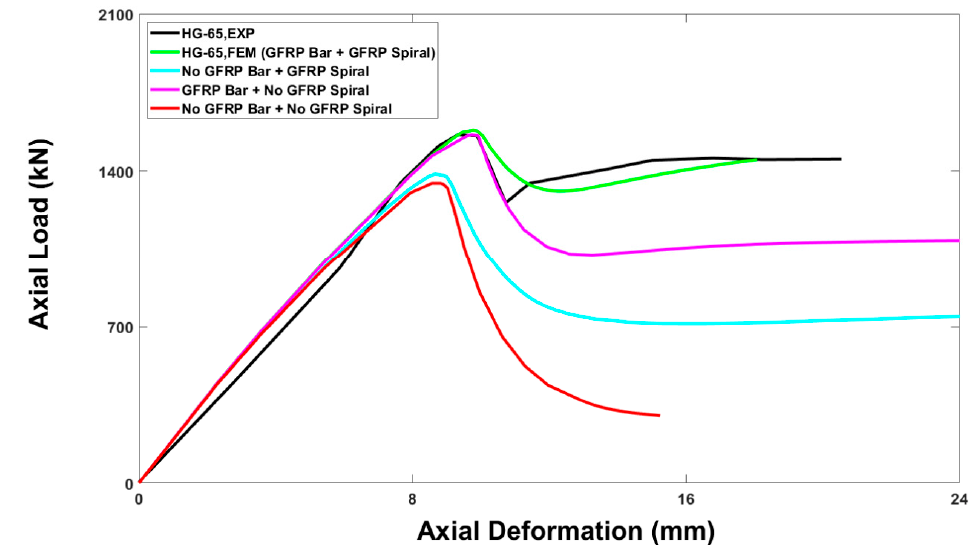
Figure 20. Effect of provision of longitudinal and transverse reinforcements.